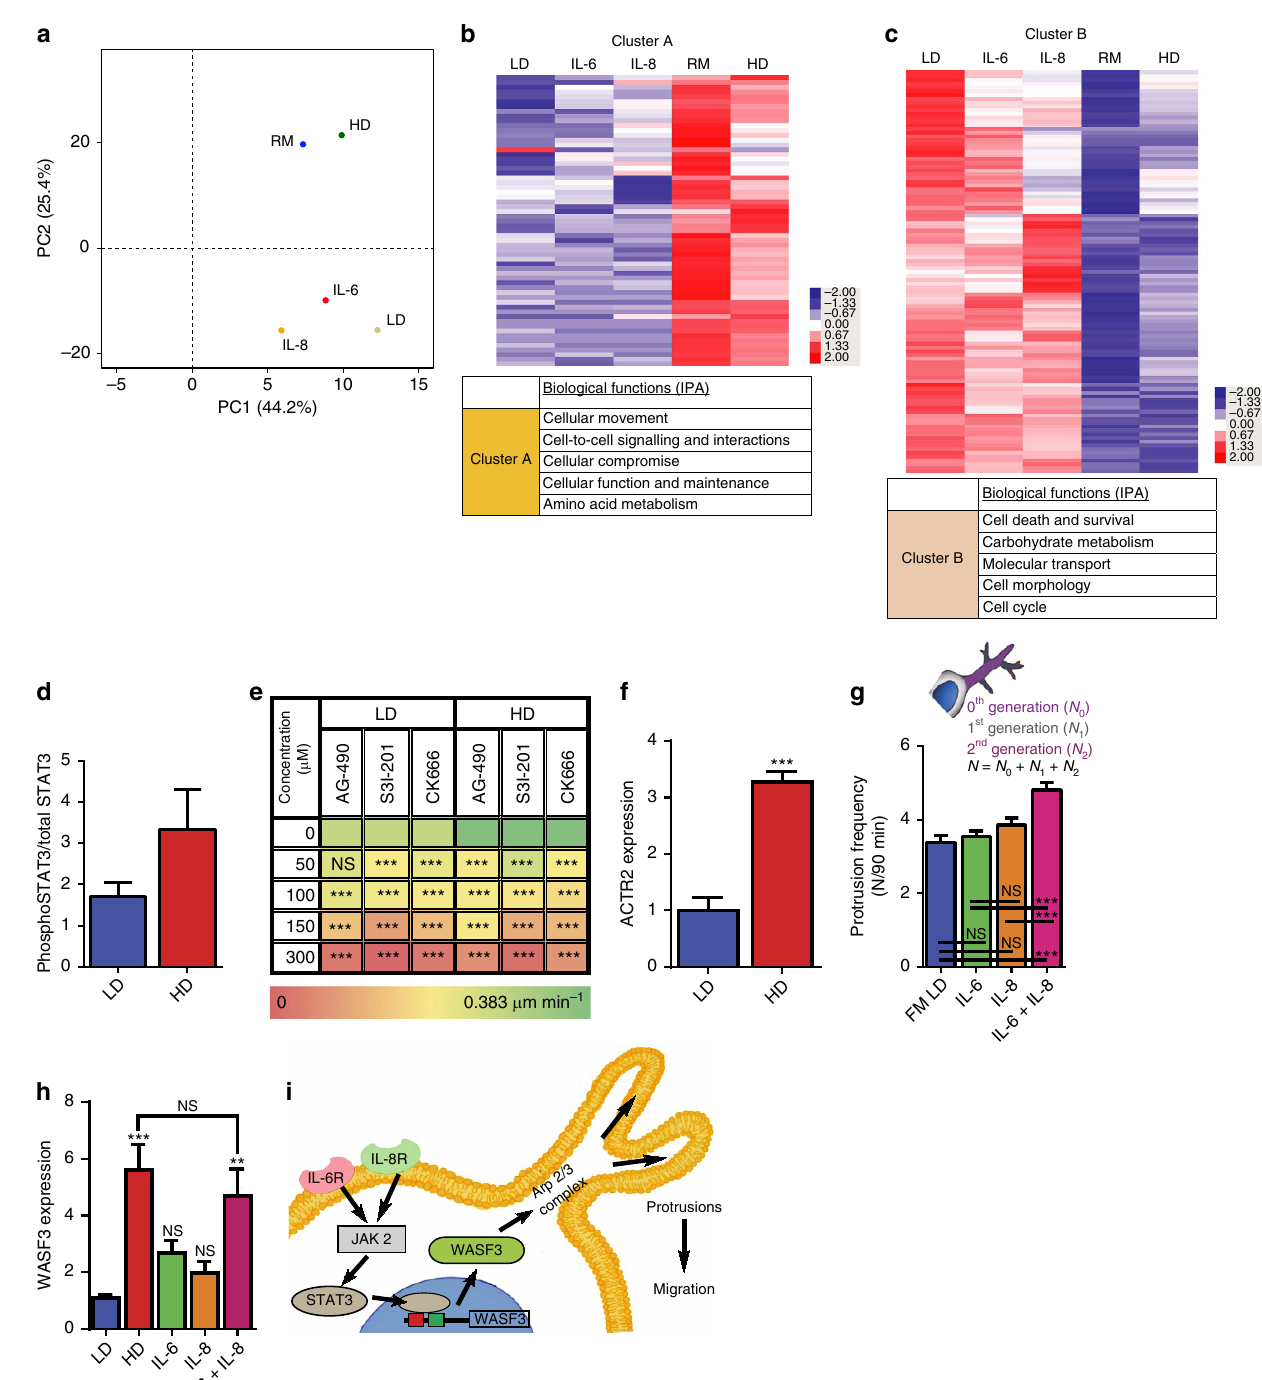
Figure 4 | Proposed mechanism. ( a ) Principle component analysis (PCA) of the top 930 most significant genes to determine the relationship of global transcriptomes. ( b ) Heat map demonstrating the difference between gene ontology categories. ( c ) Table demonstrating gene ontology categories. ( d ) Activity of STAT3 in 3D conditions at LD ( r ¼ 10) and HD ( r ¼ 50). ( e ) Decreased cell speed of human fibrosarcoma cells embedded in a 3D matrix exposed to JAK2 inhibitor, AG-490, STAT3 inhibitor, S3I-201, and Arp2/3 complex inhibitor, CK 666, at LD ( r ¼ 10) and HD ( r ¼ 50) compared with cells exposed to fresh medium (0). ( f ) Increased mRNA expression of ACTR2 at HD. ( g ) The addition of recombinant IL-6 and IL-8 alone does not increase protrusion frequency, however the addition of recombinant IL-6 and IL-8 in combination at the precise concentrations found in a matrix containing a high density of 50cellsmm (cid:2) 3 (RM) significantly increases the frequency of cellular protrusions. ( h ) Increased mRNA expression of WASF3 at HD and cells exposed to recombinant IL-6 and IL-8 in combination at the precise concentrations found in a matrix containing a high density of 50cellsmm (cid:2) 3 . ( i ) Cartoon depiction of the IL-6 and the IL-8 signalling pathway leading to enhanced cell motility. In all panels, data is represented as mean ± s.e.m. from three independent experiments. * P o 0.05; ** P o 0.01; *** P o 0.001 (ANOVA).